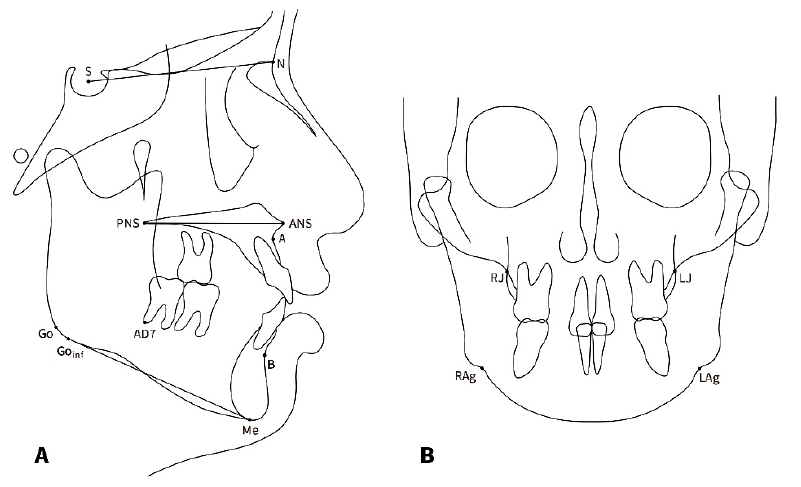
Figure 2. ( A ). Landmarks and planes on a lateral cephalogram. S, sella; N, nasion; ANS, anterior nasal spine; PNS, posterior nasal spine; A, point A; B, point B; Me, menton; Go, gonion; Go inf , inferior gonion; AD7, apex of the distal root of the mandibular second molar; SN plane, line from S to N; palatal plane, line from ANS to PNS; mandibular plane, line from Me to Go inf . ( B ). Landmarks on a posteroanterior cephalogram. RJ, right jugale; LJ, left jugale; RAg, right antegonion; LAg, left